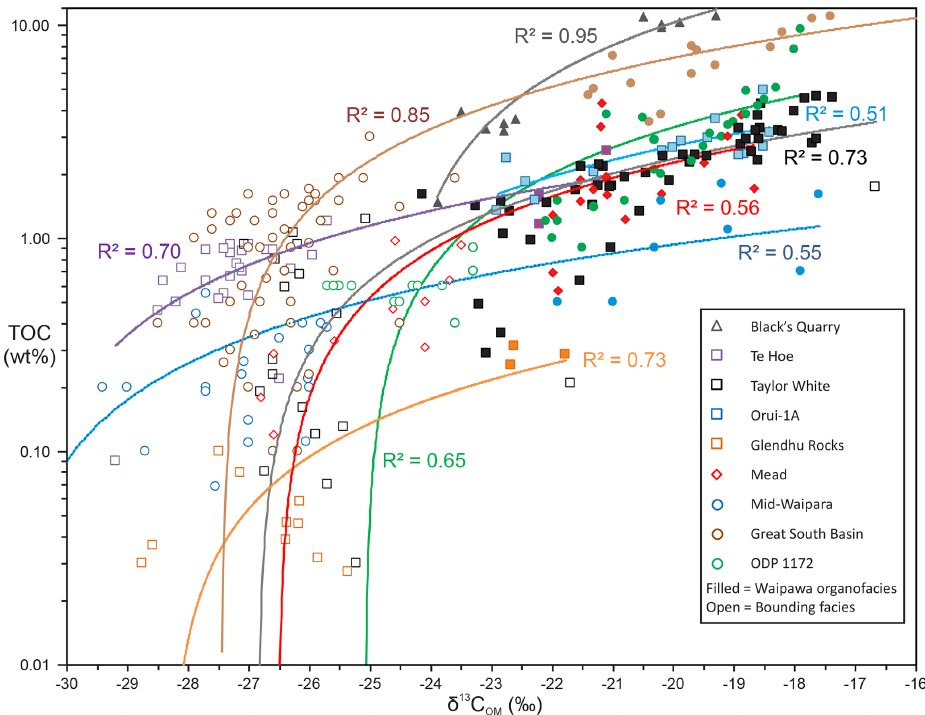
Figure 3. Correlation between TOC and δ 13 C OM in the studied sections. Correlation coefficients ( R 2 ) relate to the linear regression lines of the same colour. Great South Basin (GSB) drill holes include Hoiho-1C, Kawau-1A, Pakaha-1 and